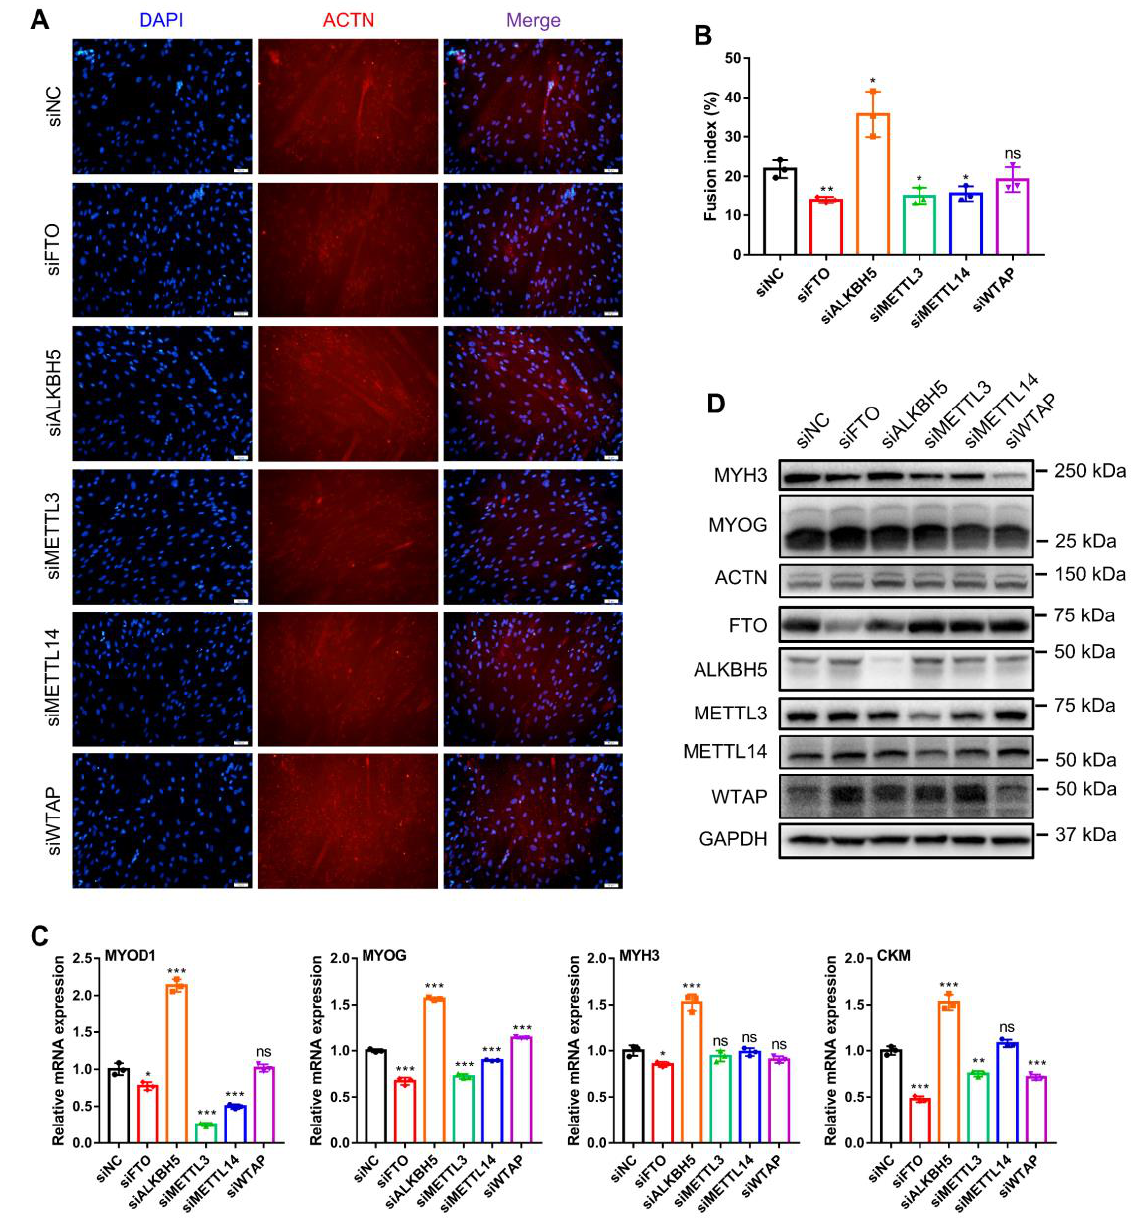
Figure 5. Knockdown of m 6 A methylase genes regulates bovine myoblast differentiation. Bovine myoblasts were induced for myogenic differentiation 24 h after transfection with siNC or siRNAs (siFTO, siALKBH5, siMETTL3, siMETTL14 or siWTAP). ( A ) Fluorescence staining of MYHC protein (red) indicates myotube formation on day 3 of myoblast differentiation. Nuclei were stained with DAPI (blue). ( B ) The fusion index was calculated as the percentage of nuclei in fused myotubes out of the total number of nuclei. For each group, three random microscopic fields were selected randomly. ( C ) RT-qPCR was performed to detect the relative mRNA expression of MYOD1 , MYOG , MYH3 and CKM on day 3 of myoblast differentiation. GAPDH was the normalization control. ( D ) Western blot assays demonstrating the expression levels of MYH3, MYOG, ACTN, FTO, ALKBH5, METTL3, METTL14, WTAP and GAPDH proteins in different treated cells. ( B , C ) Results are presented as the means ± SDs from three independent experiments. Using Student’s t test, * p < 0.05, ** p < 0.01, *** p < 0.001 and ns = no significance.